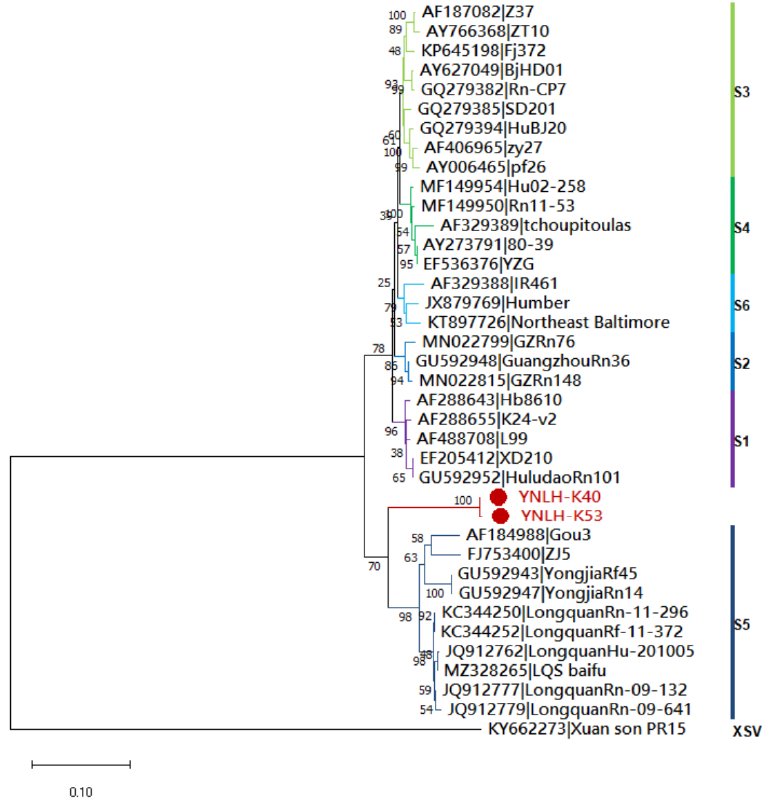
Figure 3. Phylogenetic tree constructed using nucleotide sequences of the Seoul virus partial S-segment gained from Yunnan Province, China. Thirty-five representative Orthohantavirus se- quences were included for comparison, and one Xuan son virus sequence was used as the out- group. Note: the red circles represent the newly discovered HV sequences in this study.